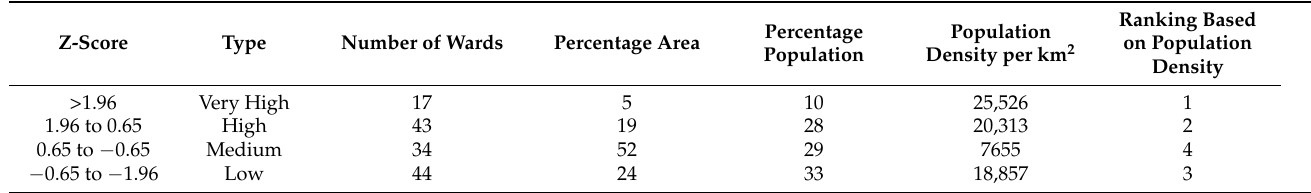
Table 3. Fire risk zone classification for hotspot analysis (Getis-Ord Gi*) of census wards.